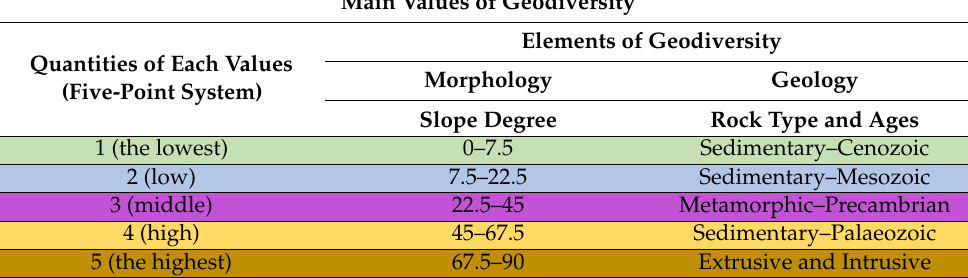
Table 3. The evaluation system of the main values of geodiversity. The table shows the summary of grades and underlying values of four elements of core geodiversity. Morphology can be assessed according to the steepness of the slope, with geology and rock types and their ages also dependent on amount of surface exposure. Colour codes are used as guide to better distinguish various rocks types by their